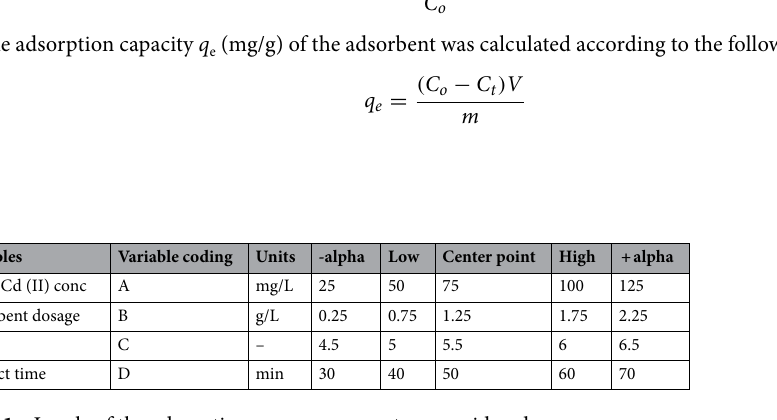
Table 1. Levels of the adsorption process parameters considered.